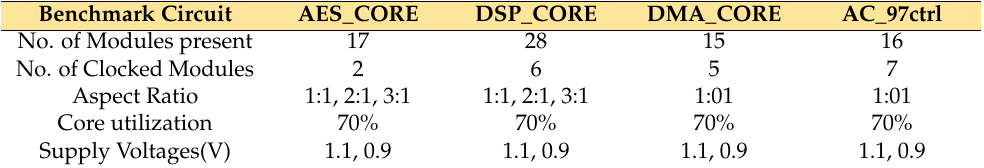
Table 2. The hardware description of Cadence Innovus for the Specification of design at the 45 nm node.